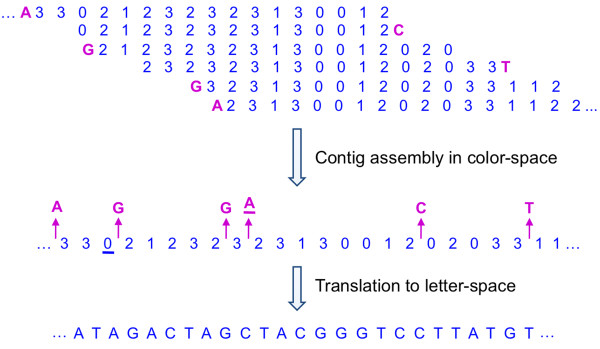
Robust translation from color-space to base-space. The base-space suggestions, obtained by translating only the first color call of each read, are shown in magenta. Contig assembly is performed using only the color part (indicated by numbers 0-3) of each sequence. Inconsistencies between the color-space calls and the base-space suggestions, signals the presence of errors. We use an error probability model to find the most likely DNA sequence consistent with this data. The underlined color calls and suggestions in the figure are declared as mistakes in the final translation.